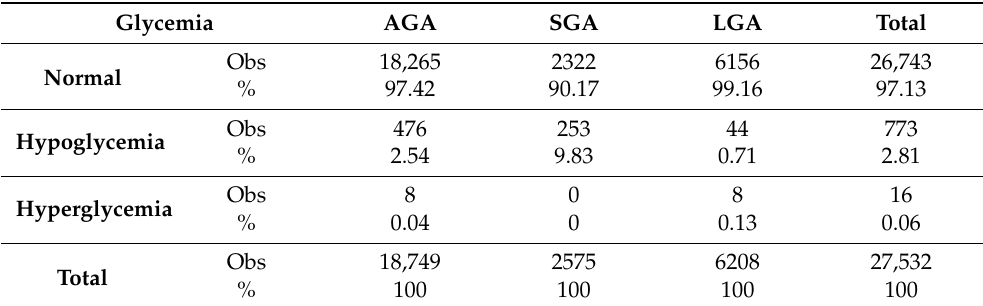
Figure 5. Correlation between glycemia and weight for gestational age. AGA, appropriate for ges- tational age; SGA, small for gestational age; LGA, large for gestational age. Table 4. Association between weight for gestational ages (GAs) and blood glucose alterations regardless of the type of nutrition. AGA, appropriate for gestational age; SGA, small for gestational age; LGA, large for gestational age.